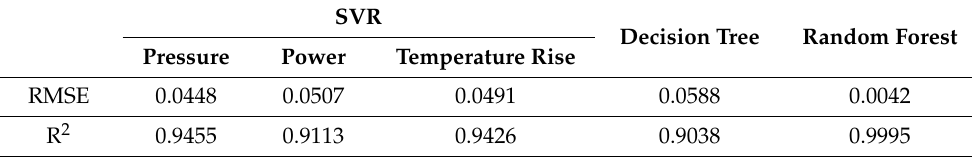
Table A1. The cross-validation error and accuracy in grid-search. SVR